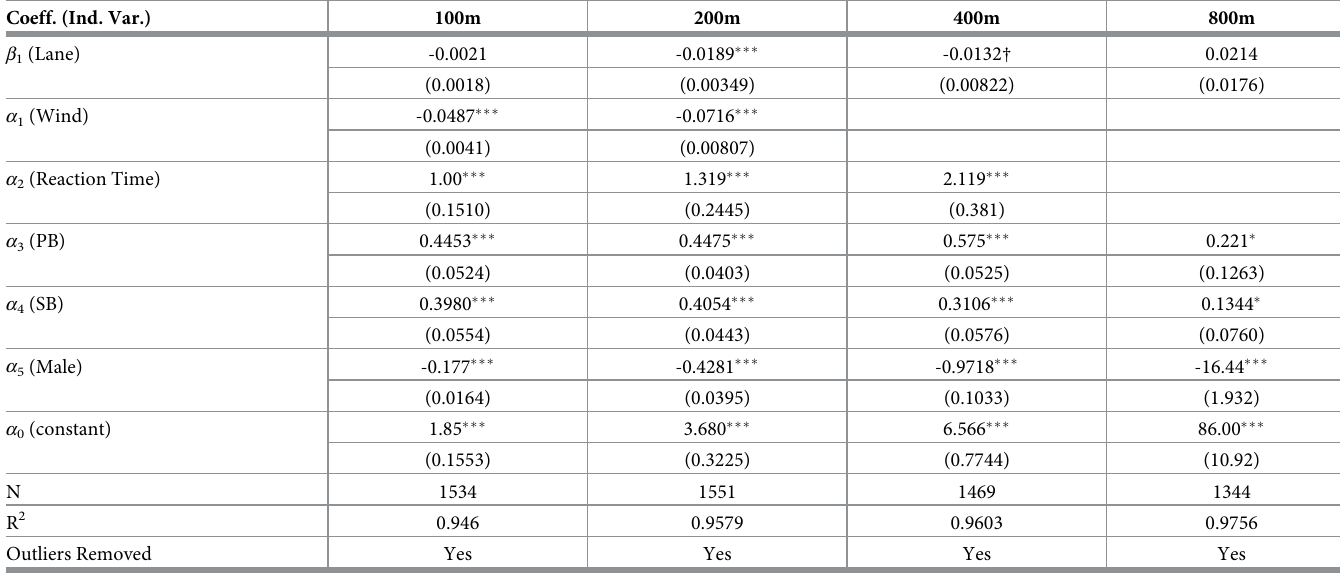
Table 8. Regression results with lane effects modeled linearly. Coeff. (Ind.